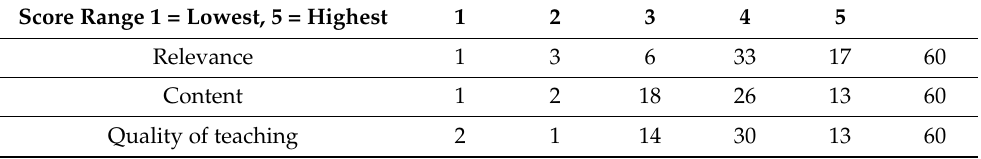
Table 3. Student scores of the relevance, content, and quality of teaching of subjects (no. of students). Score Range 1 = Lowest, 5 = Highest 1 2